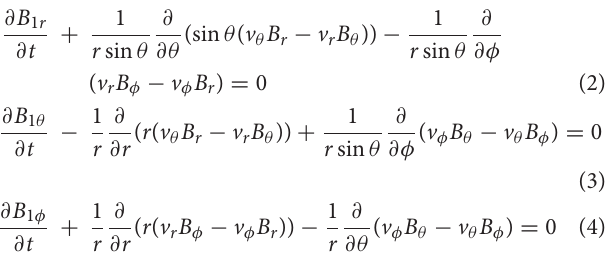
Frontiers in Astronomy and Space Sciences |